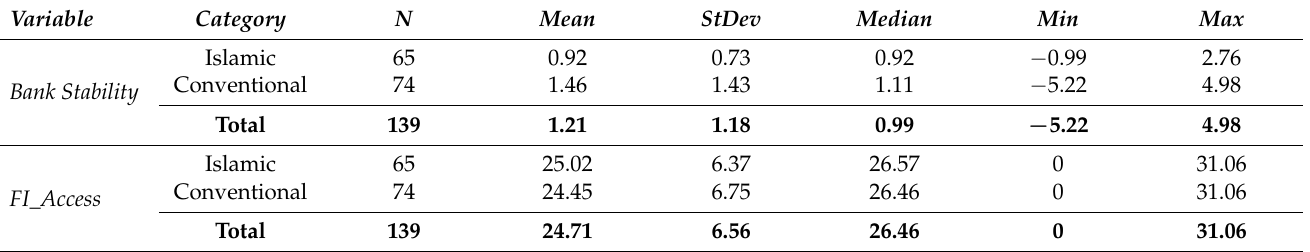
Table 3. Descriptive statistics for the total sample as well as for Islamic and conventional